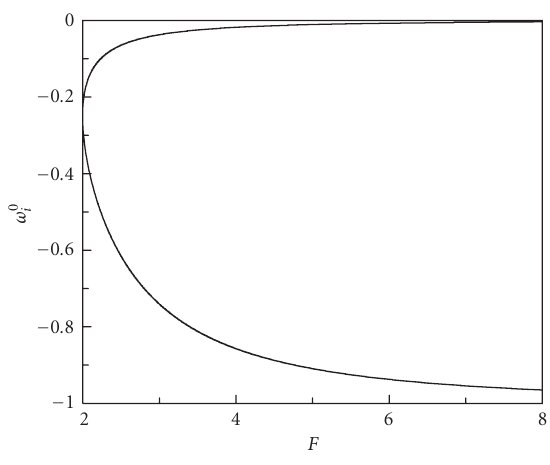
Figure 3.2. Imaginary part of finite pinch-type singularities versus Froude